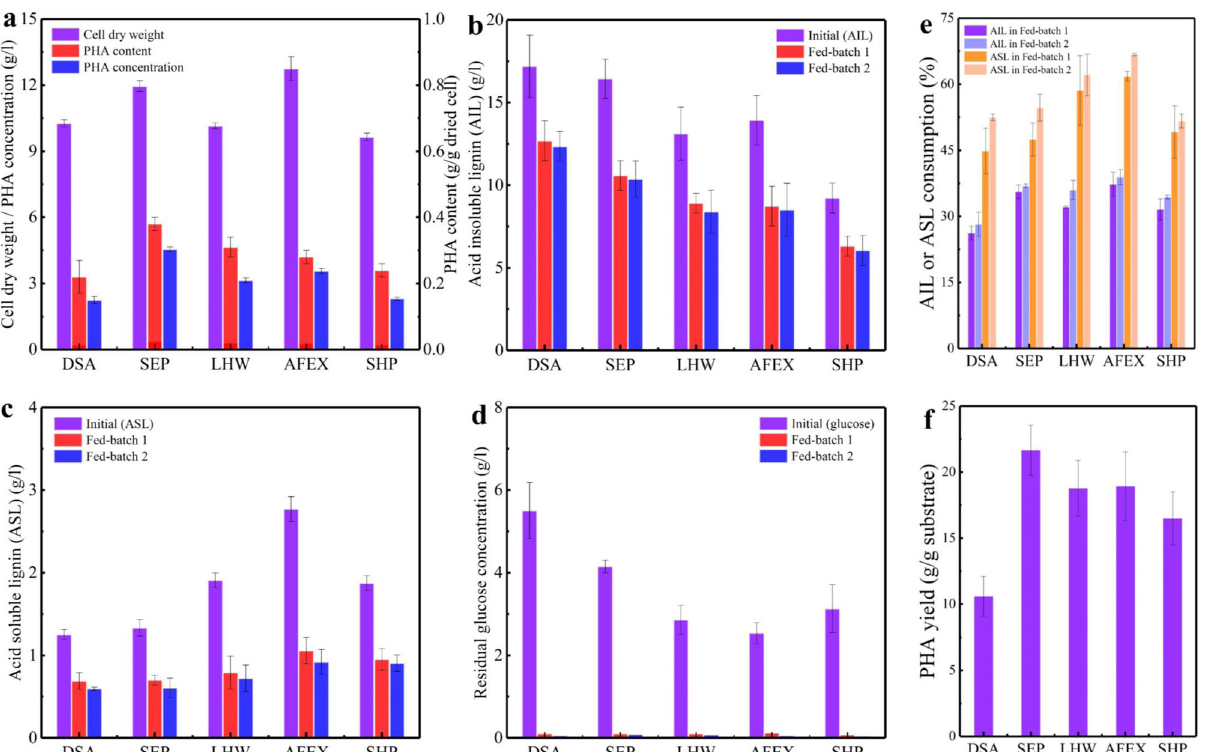
Fig. 4 The microbial conversion of the soluble lignin to polyhydroxyalkanoates (PHAs). a It represents cell dry weight, PHA concentration, and PHA content in fed-batch fermentation using different soluble lignins as carbon sources; b , c It represents the concentration of the acid insoluble and acid soluble lignin, respectively; d It represents the concentration of residual sugar; e It represents the lignin consumption in fed-batch fermentation; f It represents PHA yield based on the consumption of substrates. AIL acid insoluble lignin, ASL acid soluble lignin, DSA dilute sulfuric acid pretreatment, SEP steam explosion pretreatment, LHW liquid hot water pretreatment, AFEX ammonia fi ber expansion, SHP sodium hydroxide pretreatment. Initial represents the initial concentration (acid insoluble lignin, acid soluble lignin, and residual glucose). Error bars represent the standard